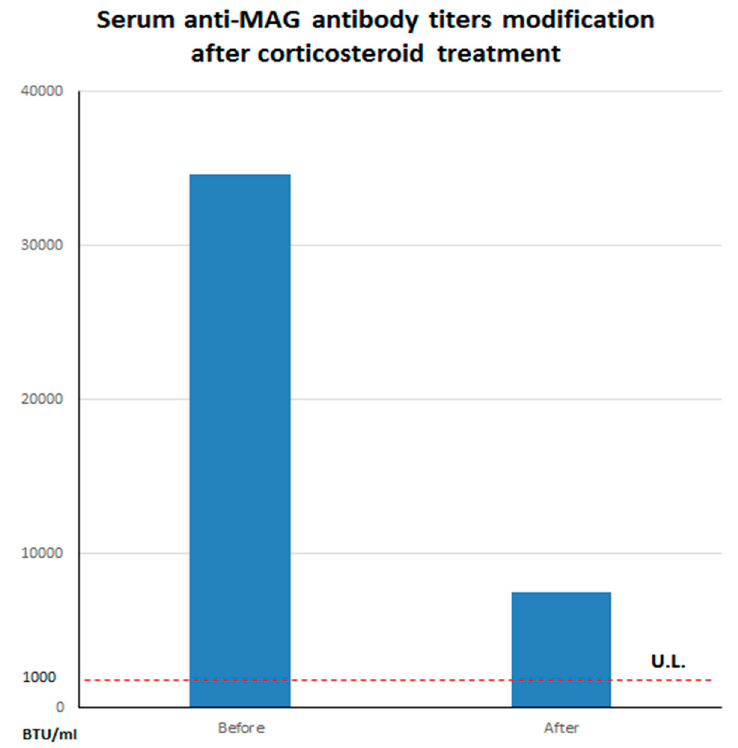
Figure 3. Serum anti-myelin associated glycoprotein (anti-MAG) titers modification after corticosteroid treatment. Please note the substantial decrease of serum antibody levels before (34,594 BTU/mL) and after (7520 BTU/m L ) corticosteroid treatment. The dashed line refers to the upper limits (U.L.) of normal for our laboratory (~1000 BTU/mL).